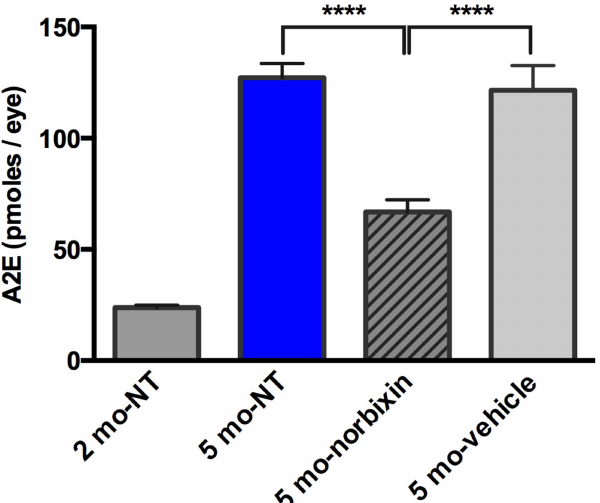
Fig 8. A2E quantification after norbixin water supplementation. Two-month-old Abca4 -/- Rdh8 -/- mice were treated for 3 months with drinkingwater supplemented with 0.5 mg/mL norbixinor vehicle. Eyes from five-month old and two-month old Abca4 -/- Rdh8 -/- mice were also analysedand served as controls. NT: non treated. Data represent the mean +/- s.e.m. of 2 separate experiments with n = 5. **** p < 0.0001 comparedto norbixin-treated mice (One-wayANOVA, Dunnett’s post